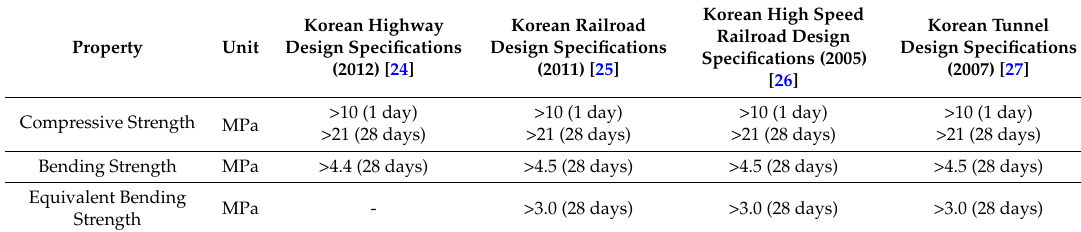
Table 4. Korean design guidelines for tunnel shotcrete.